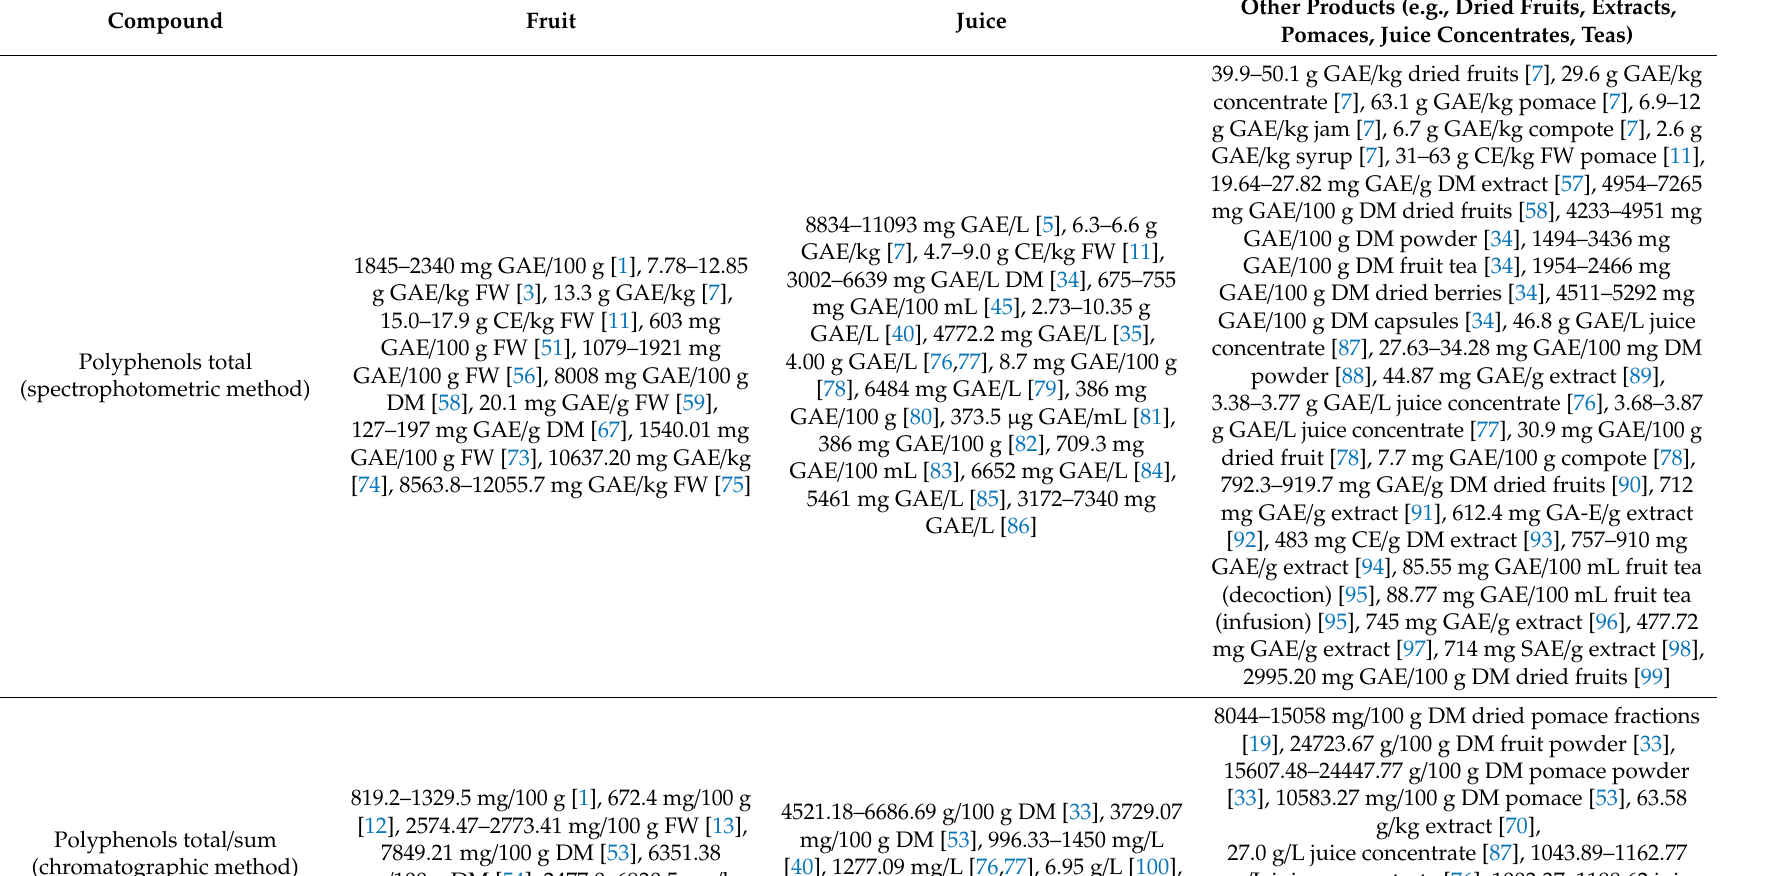
Table 2. The qualitative composition of selected polyphenols present in black chokeberry fruits, juices and other products.